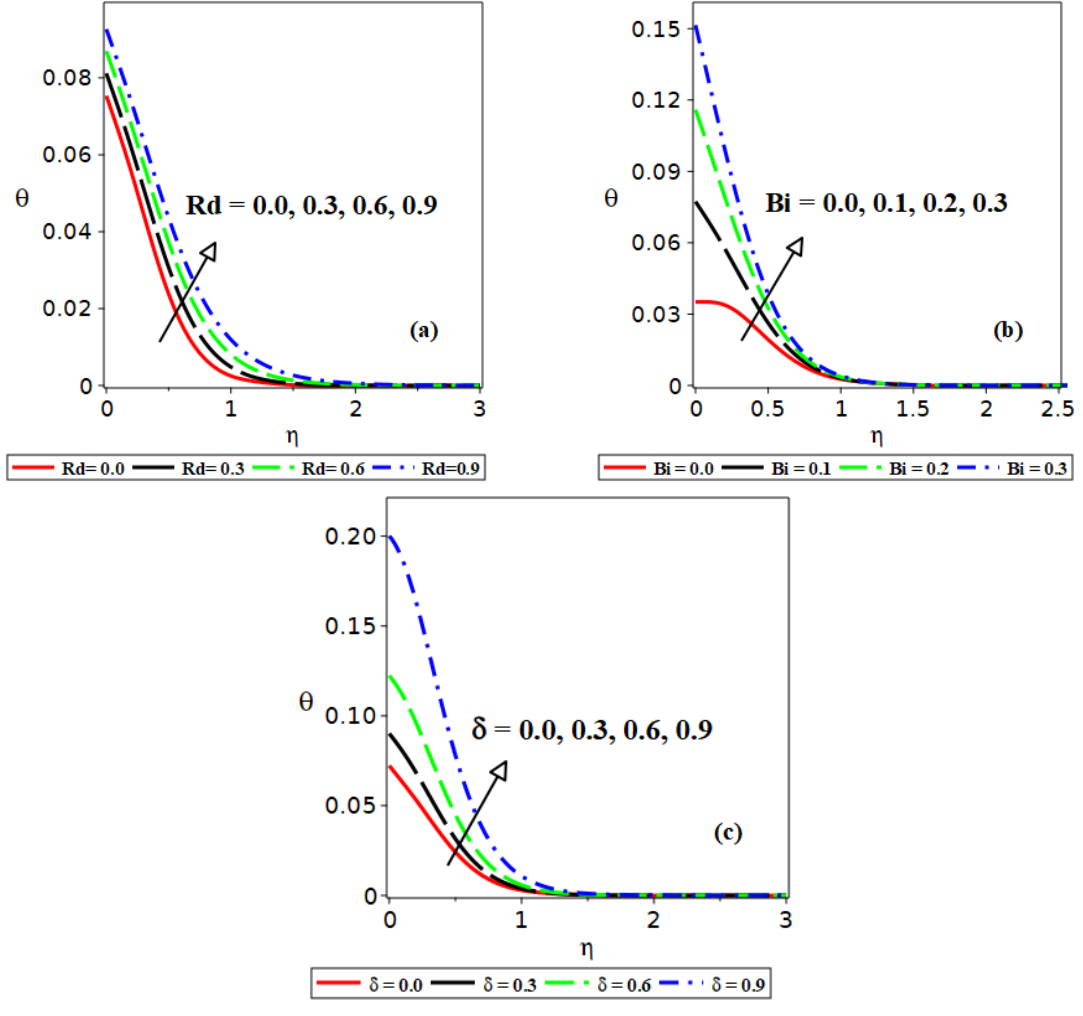
Figure 4. Variation of 𝜃(𝜂) on ( a ) Rd, ( b ) Bi, and ( c ) 𝛿 . The elaboration of the curves of the thermal field for a variety of different values of Rd is shown in Figure 4a. The higher rate of Rd cause the thermal field to rise, along with the boundary layer thickness associated with it. As predicted, the presence of